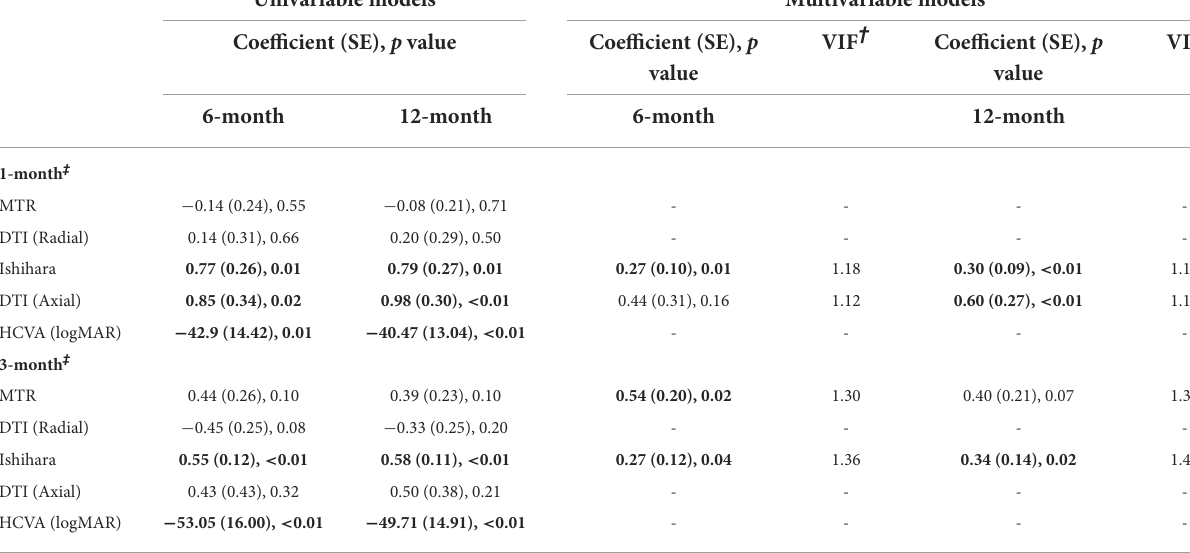
TABLE 4 mfVEP* amplitude asymmetry. Univariable